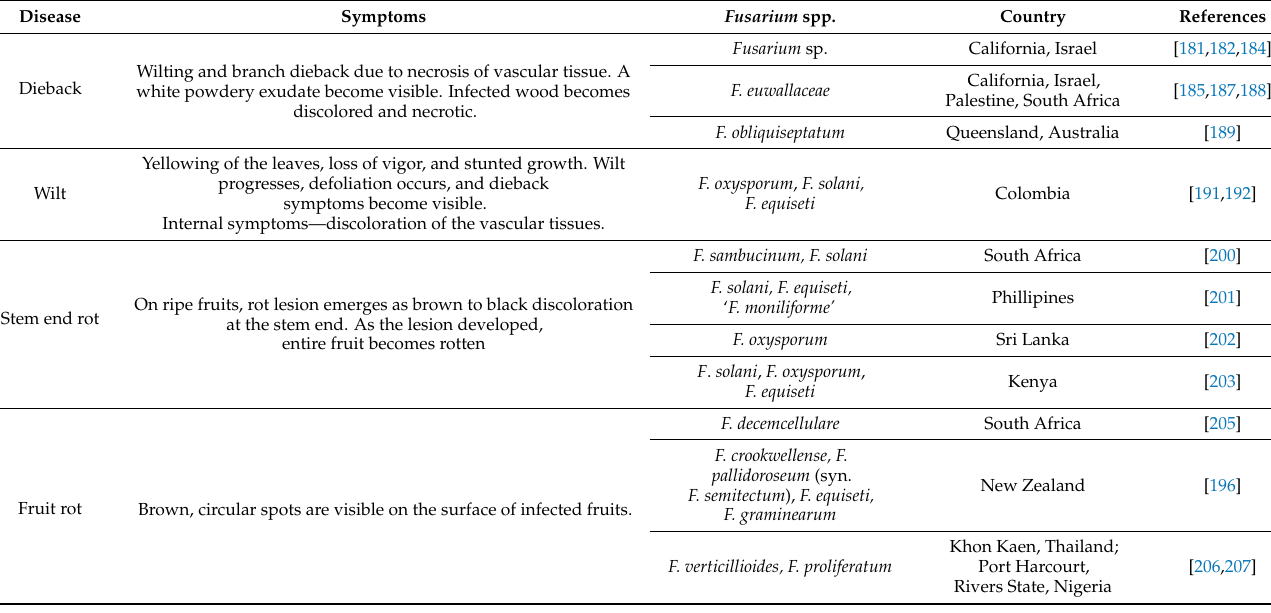
Table 5. Fusarium spp. associated with diseases of